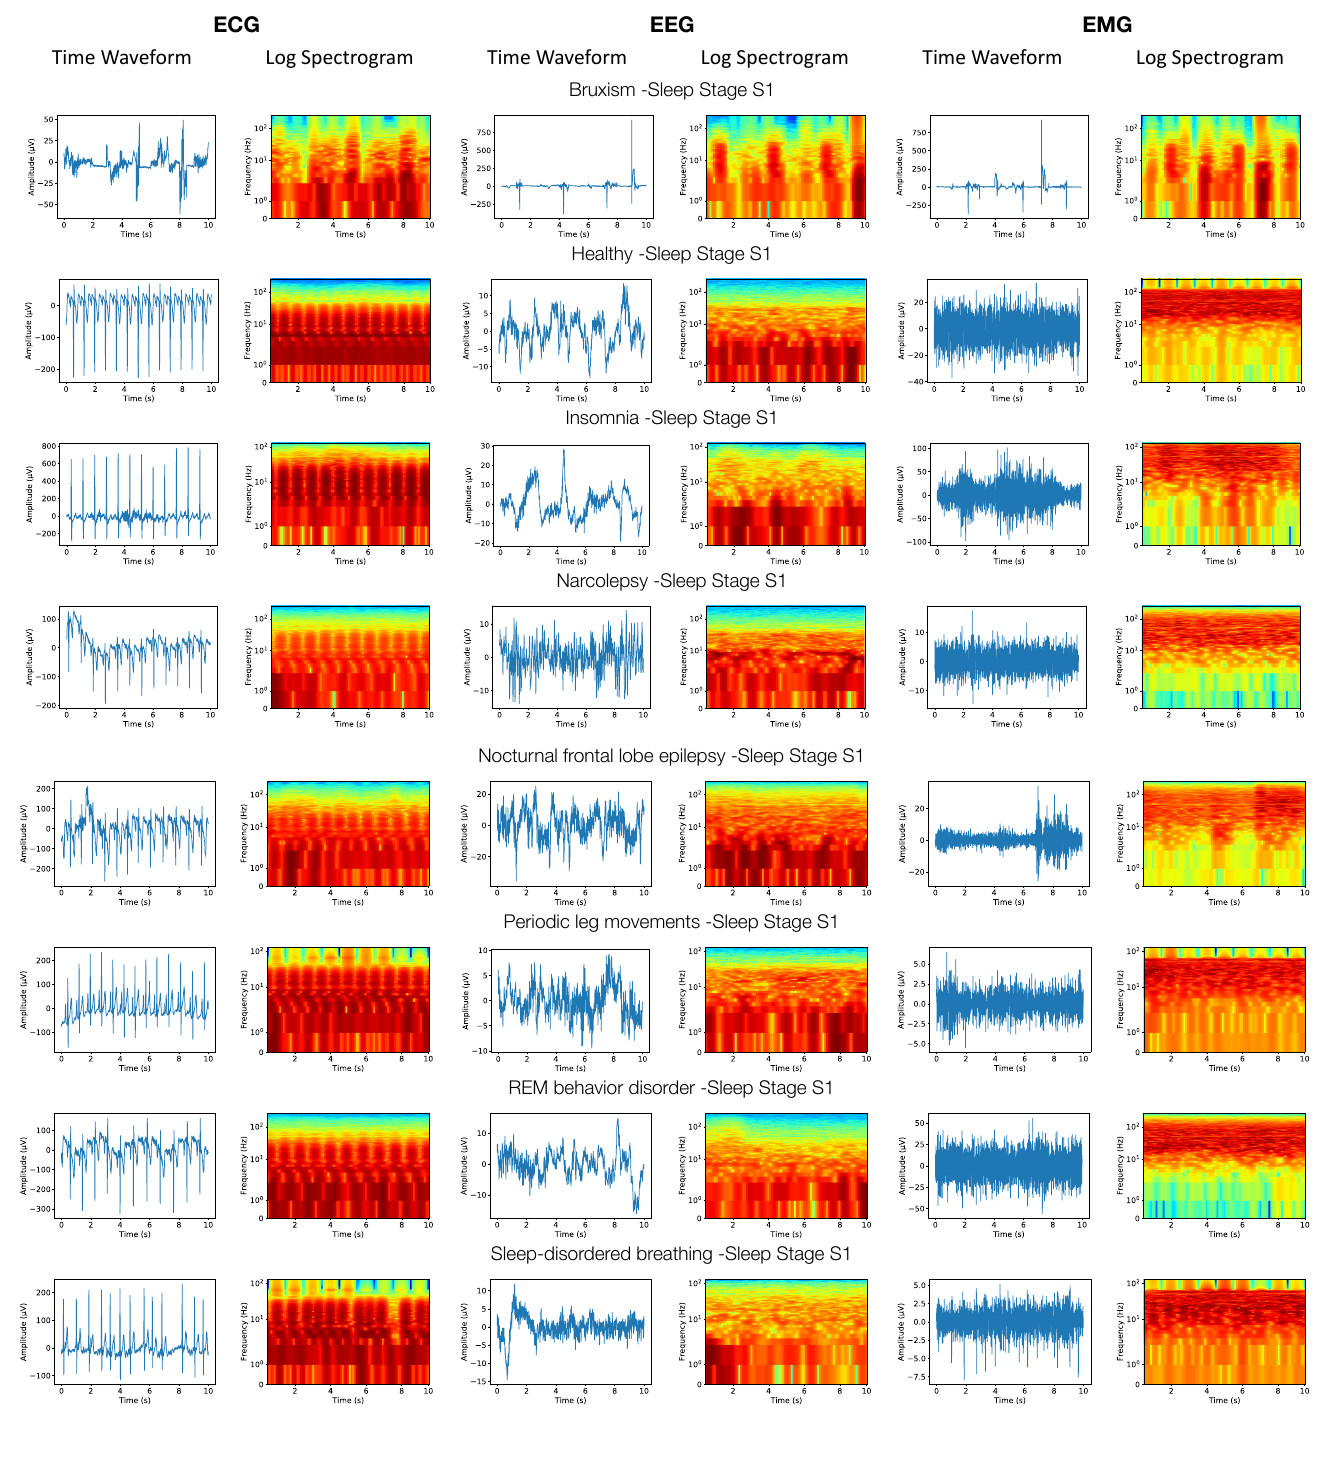
Figure 4. Examples of ECG-, EEG-, and EMG time waveforms and the corresponding logarithmic spectrograms for sleep stage S1 across different sleep